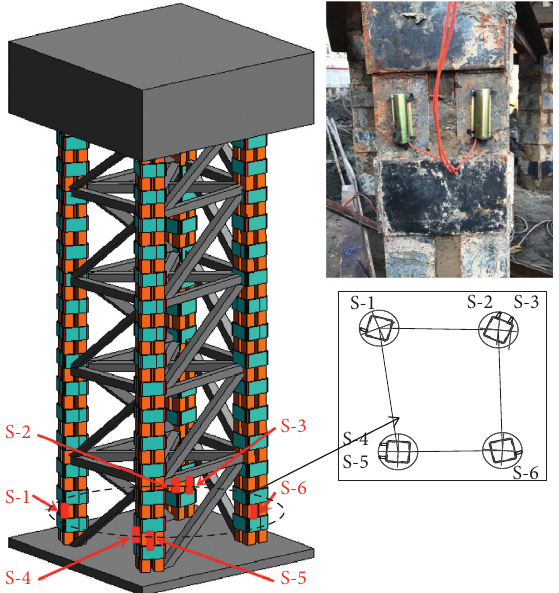
Figure 12: Stress measurement points.